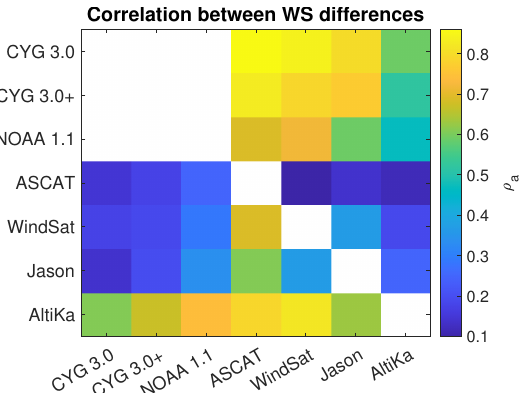
Figure 9. Image matrix of the overall correlation coefficient between wind speed differences (see Table